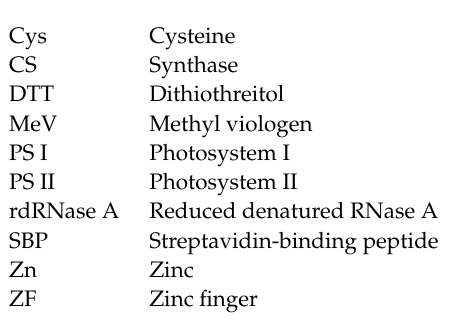
purification, Figure S6: ZnJ6 prevents the aggregation of RA at elevated temperatures, Figure S7: Chloroplast isolation from Chlamydomonas cells and pull-down assay, Figure S8: Characterization and verification of the CLiP mutant LMJ.RY0402.048147, Table S1: Mass spectrometry analysis of pulled down proteins, Table S2: Primers for recombinant protein expression, Table S3: Primers for Cysteine to Serine (TGC > TCC) mutagenesis in ZnJ6, Method S1: Cloning for recombinant protein